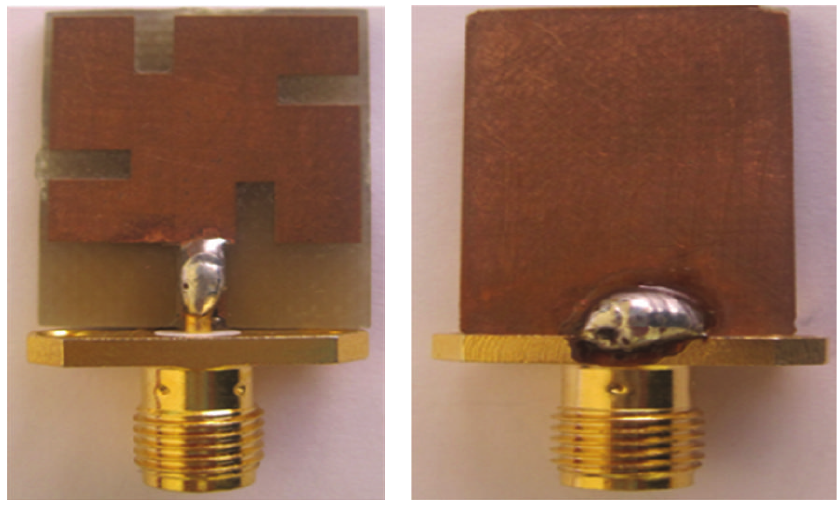
Figure 2: Photograph of the proposed antenna prototype top view and rear view, respectively.